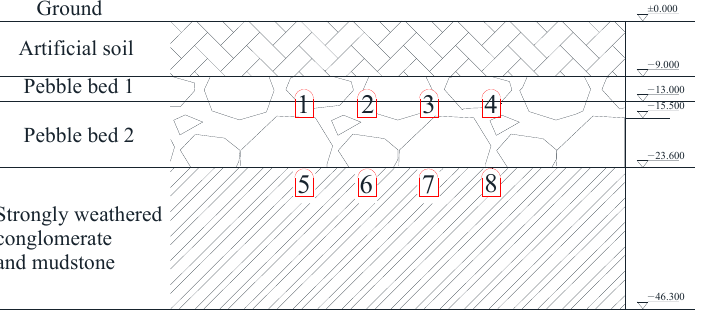
Figure 2. Numerical model: ( a ) model and ( b ) serial numbers of the pilot tunnels. Figure 3. Positions of the tunnels relative to one another.